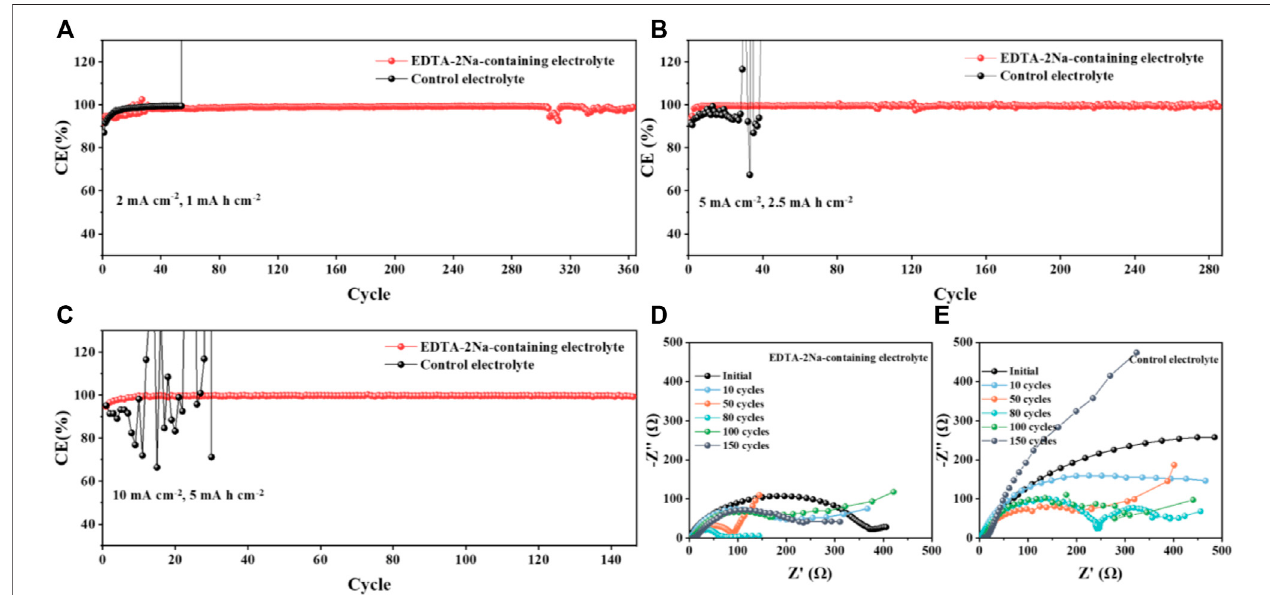
FIGURE3| SchemecaptionCEofZn||CucellswithandwithoutadditivesoftheEDTA-2Nainthecontrolelectrolytecycledunder (A) 2 mA cm − 2 and1 mA h cm − 2 , (B) 5 mA cm − 2 and 2.5 mA h cm − 2 , and (C) 10 mA cm − 2 and 5 mA h cm − 2 conditions. (D,E) EIS plots of Zn||Cu cells with and without EDTA-2Na electrolyte additive after various numbers of cycles.